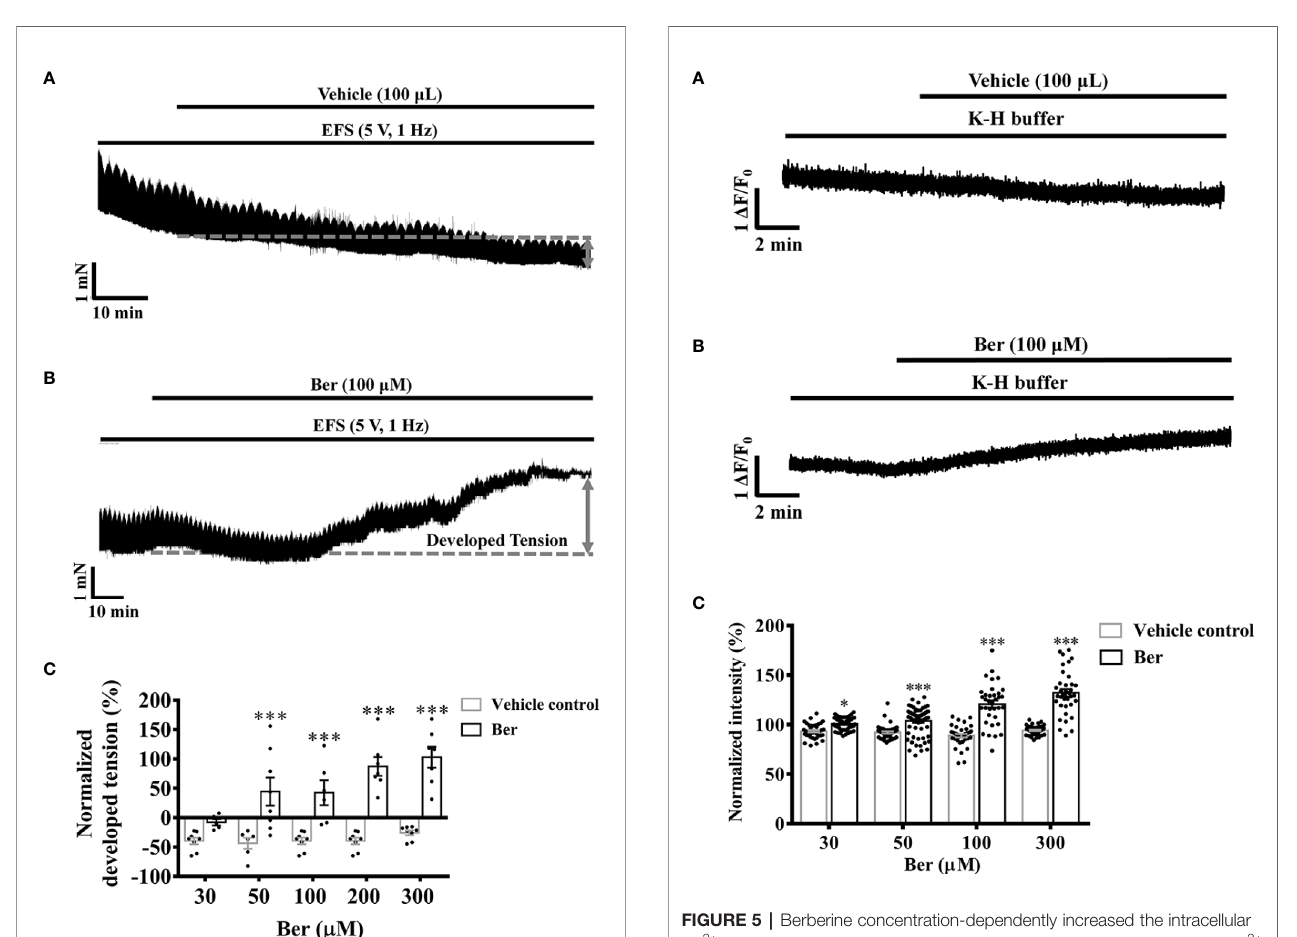
FIGURE 5 | Berberine concentration-dependently increased the intracellular Ca 2+ level of freshly isolated left ventricular (LV) myocytes. (A, B) Original Ca 2+ imaging recordings showing that berberine (100 µM) increased the intracellular Ca 2+ level of freshly isolated LV myocytes. (C) Summary data showing that berberine concentration-dependently increased the intracellular Ca 2+ level. The numbers of repeats are as follows: 30 µM Ber, n = 54, N = 3; 50 µM Ber, n = 65, N = 3; 100 µM Ber, n = 35, N = 3; 300 µM Ber, n = 36, N = 3; n and N are the numbers of LV myocytes and rats, respectively. Ber stands for berberine. *p < 0.05 , ***p < 0.001 vs. vehicle control group; two- way ANOVA with Sidak's multiple comparisons test.